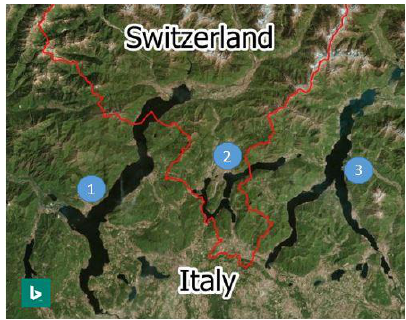
Figure 3: The area of interest; 1 - Lake Maggiore, 2 - Lake Lugano, 3 - Lake Como (Hijmans,